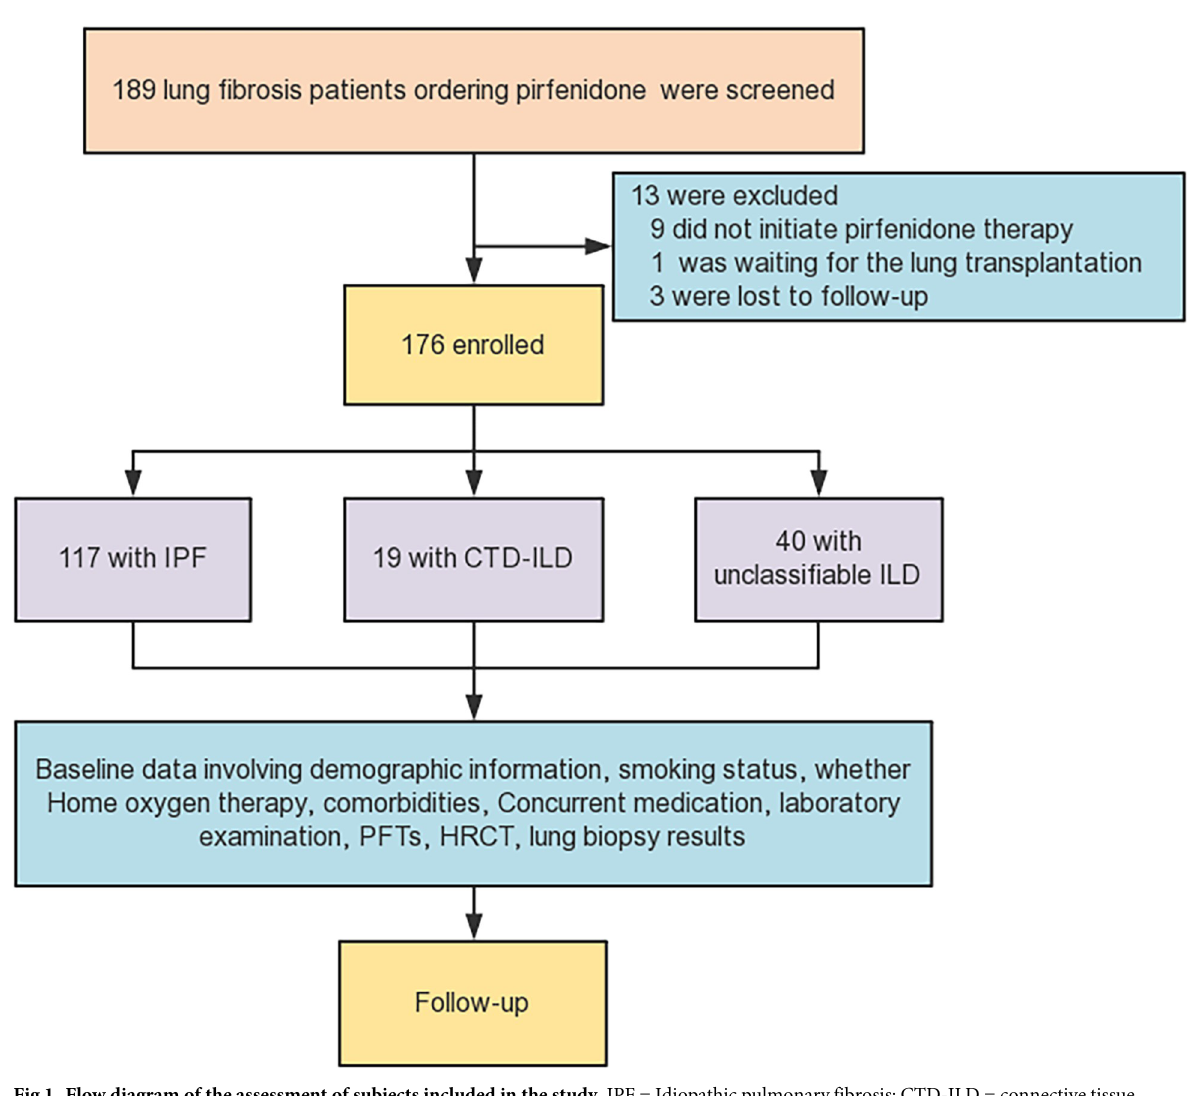
Fig 1. Flow diagram of the assessment of subjects included in the study. IPF = Idiopathic pulmonary fibrosis; CTD-ILD = connective tissue disease-associated interstitial lung disease; ILD = interstitial lung disease; PFTs = pulmonary function tests; HRCT = high-resolution computed